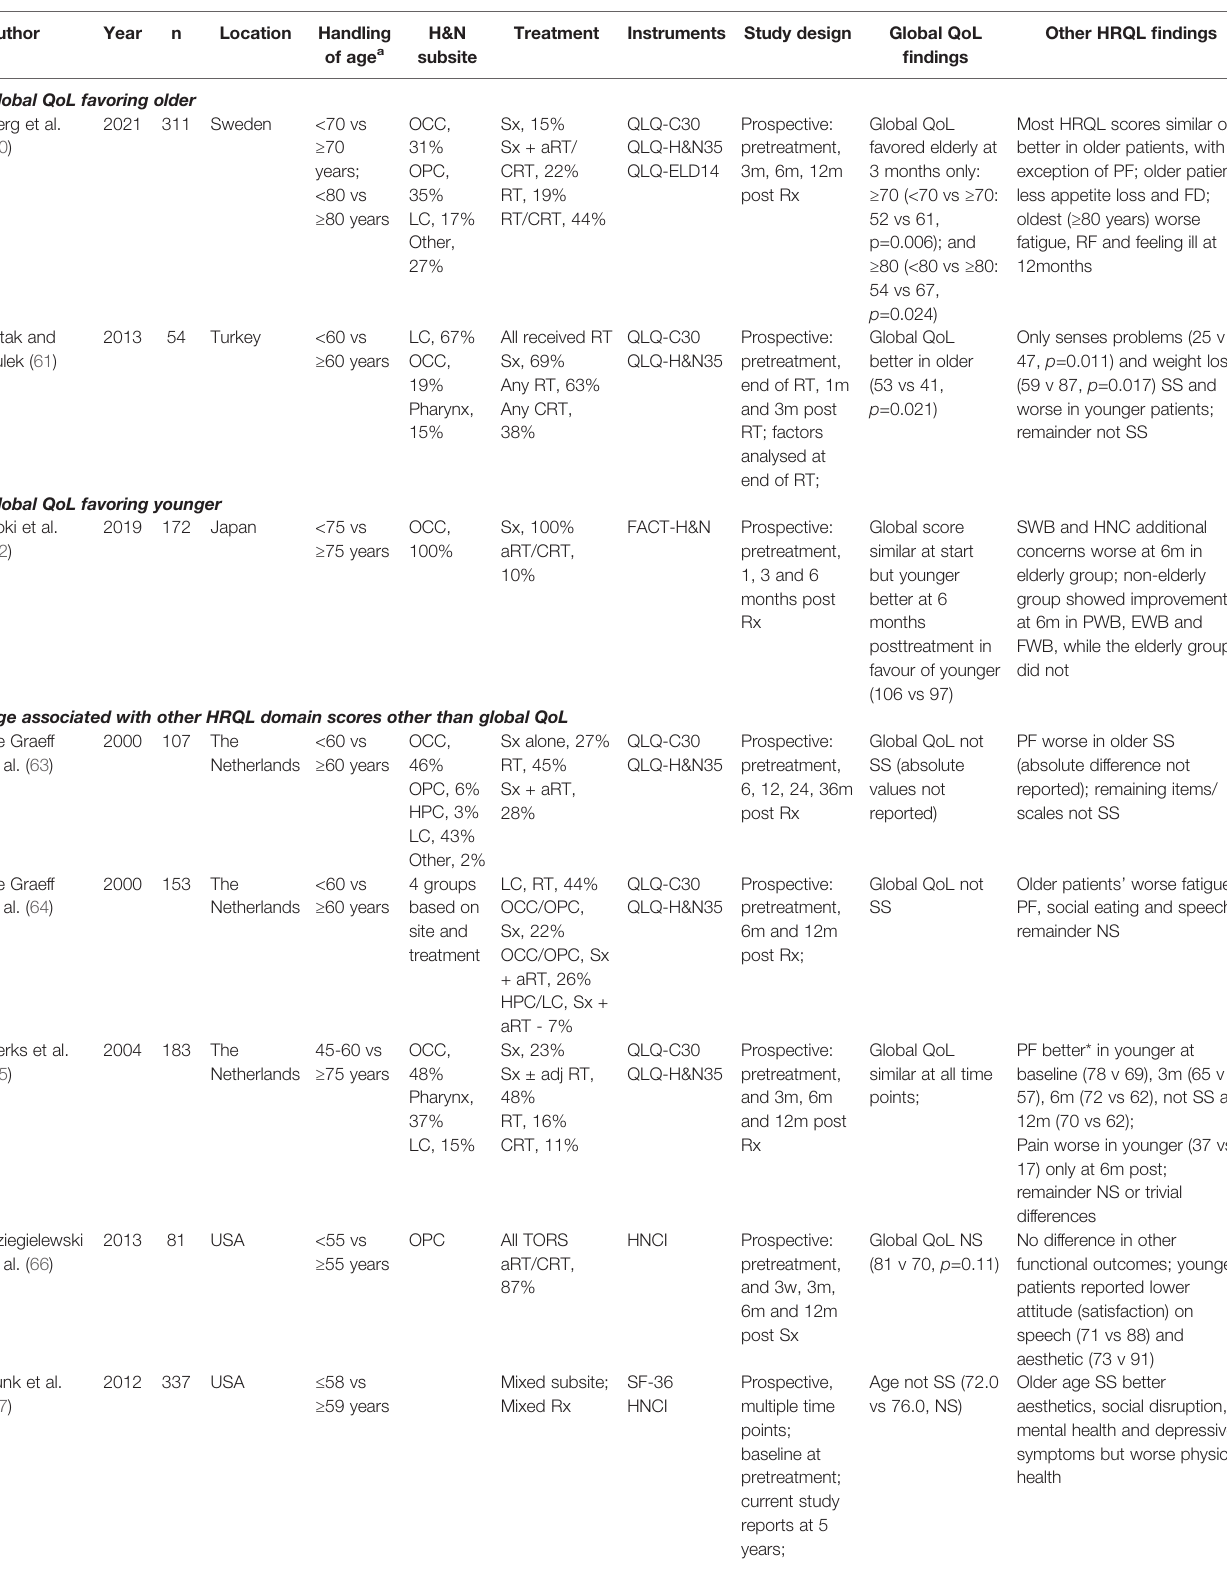
TABLE 2 | Prospective studies reporting health-reported quality of life in elderly patients a